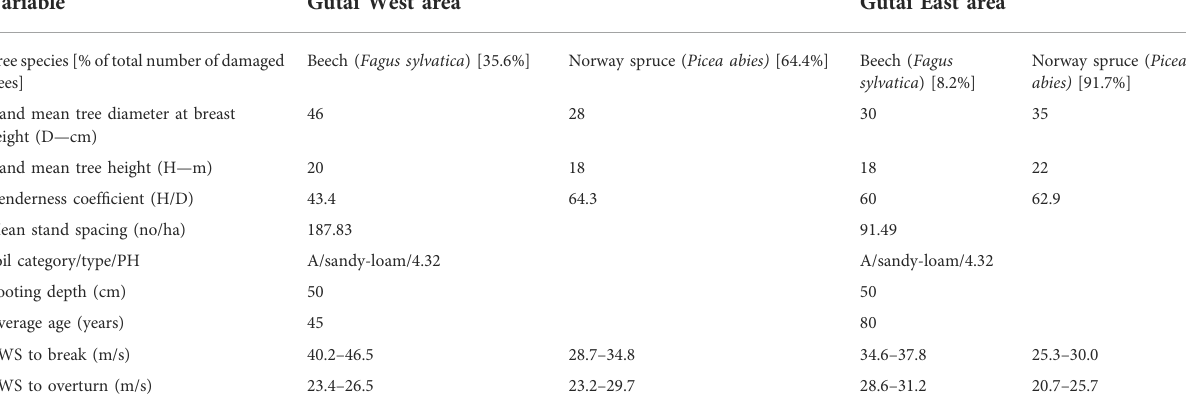
TABLE 3 Variables to calculate the critical wind speed (CWS) for windthrow and windsnap at 10 m (data source: NFM 2017 Report, OSPA Cluj, Forest GALES for conifers).